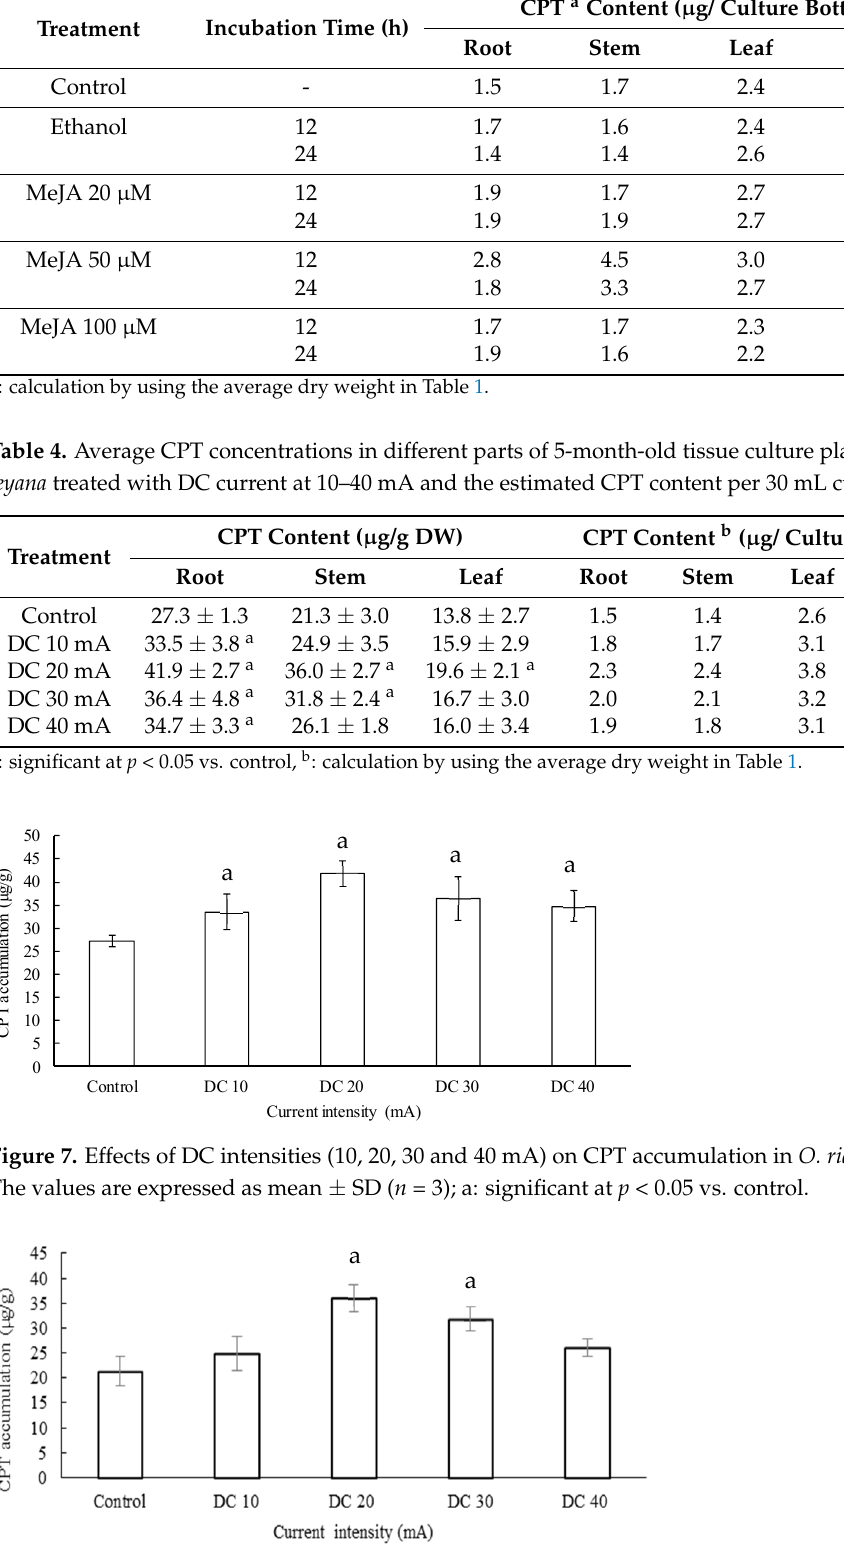
Table 3. The estimated CPT content per 30 mL culture bottle of 5-month-old tissue culture plants of O. ridleyana treated with MeJA in ethanol (0–100 µ M) compared to the control. Table 4. Average CPT concentrations in different parts of 5-month-old tissue culture CPT a Content ( µ g/ Culture Bottle) Treatment Incubation Time (h) plants of O. ridleyana treated with DC current at 10–40 mA and the estimated CPT content Root per 30 mL culture bottle.